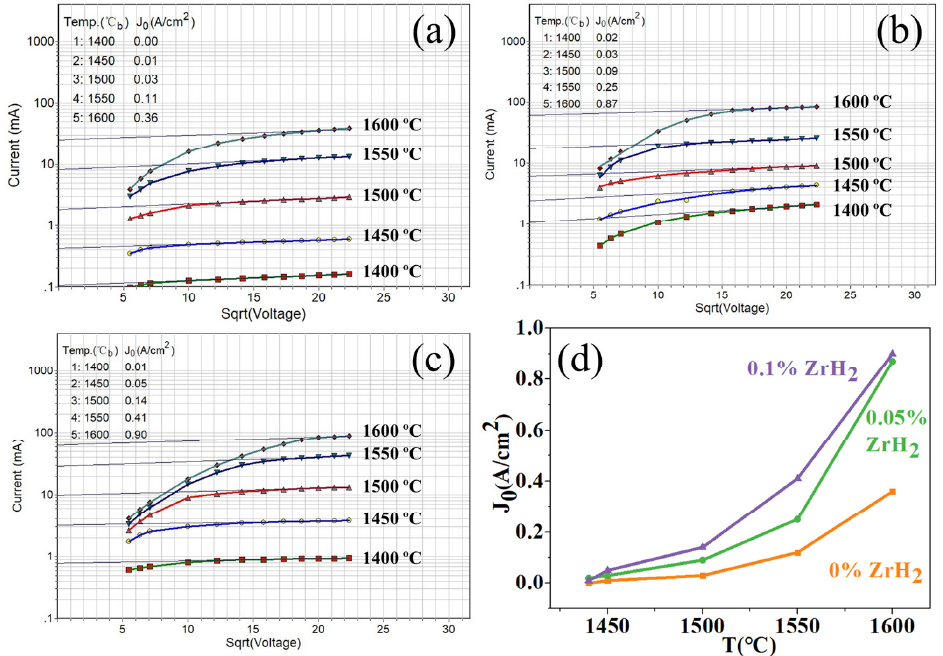
Figure 1. Volt–ampere characteristic curves ( a ) 0% ZrH 2 ; ( b ) 0.05% ZrH 2 and ( c ) 0.1% ZrH 2 ; ( d ) zero-field emission current density of the electrode materials.